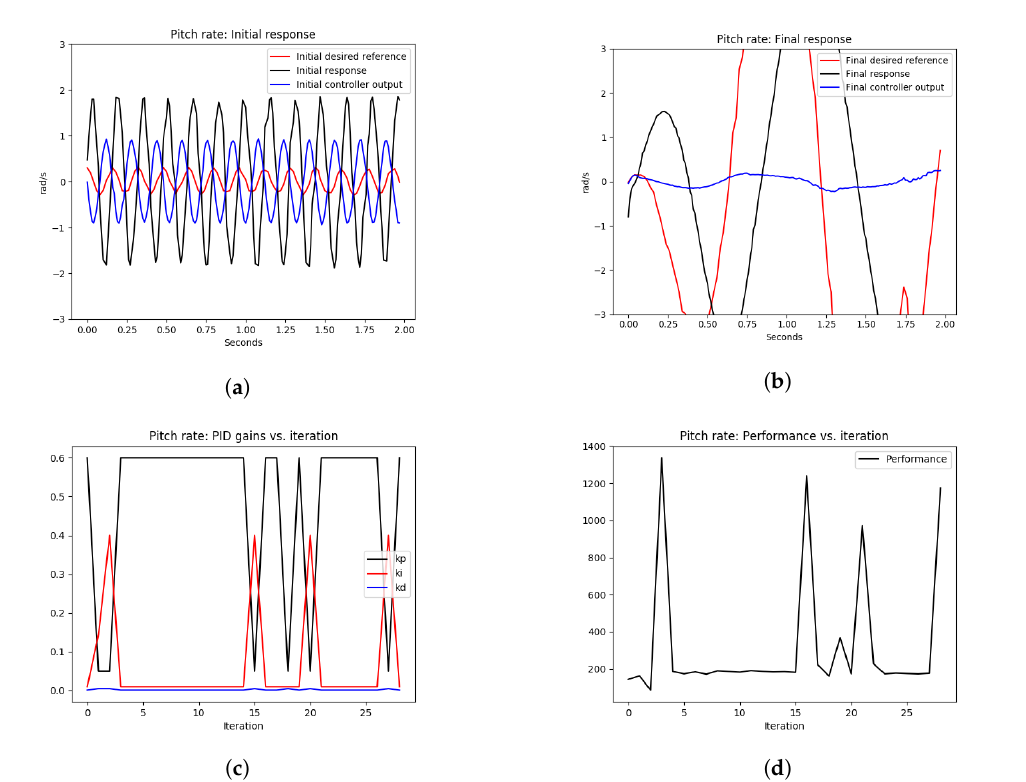
Figure 7. The pitch-rate tuning process during hovering. A fixed learning rate, α = 0.001, was used. The quadrotor started with an oscillatory angular pitch response and ended with a worse response after tuning due to the use of a non-optimal fixed learning rate. ( a ) signals before tuning, ( b ) signals after tuning, ( c ) pitch rate PID gains, ( d ) performance error V ( E ) over